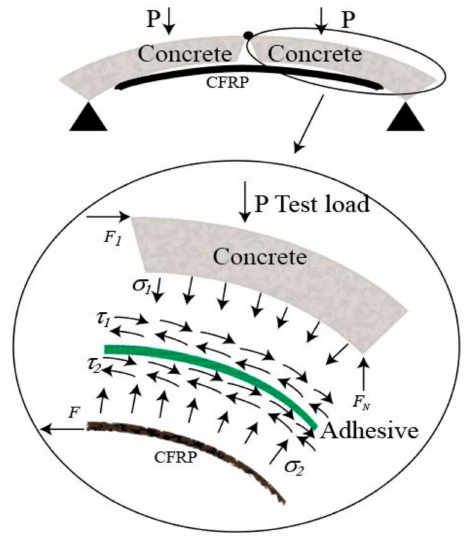
Figure A1. Relation between load and